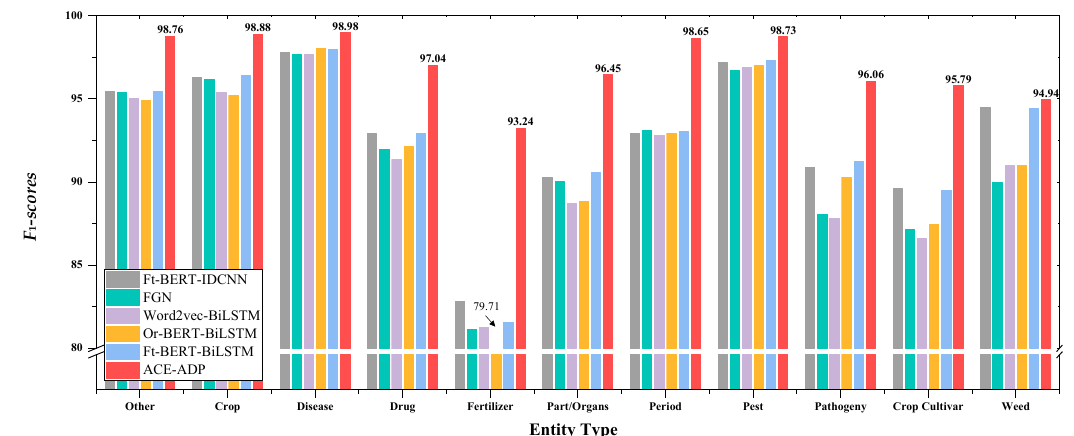
Figure 4. Detailed results of F 1 -scores for each category on AgCNER. “Ft” means the fine-tuned BERT, “Or” describes the original BERT.